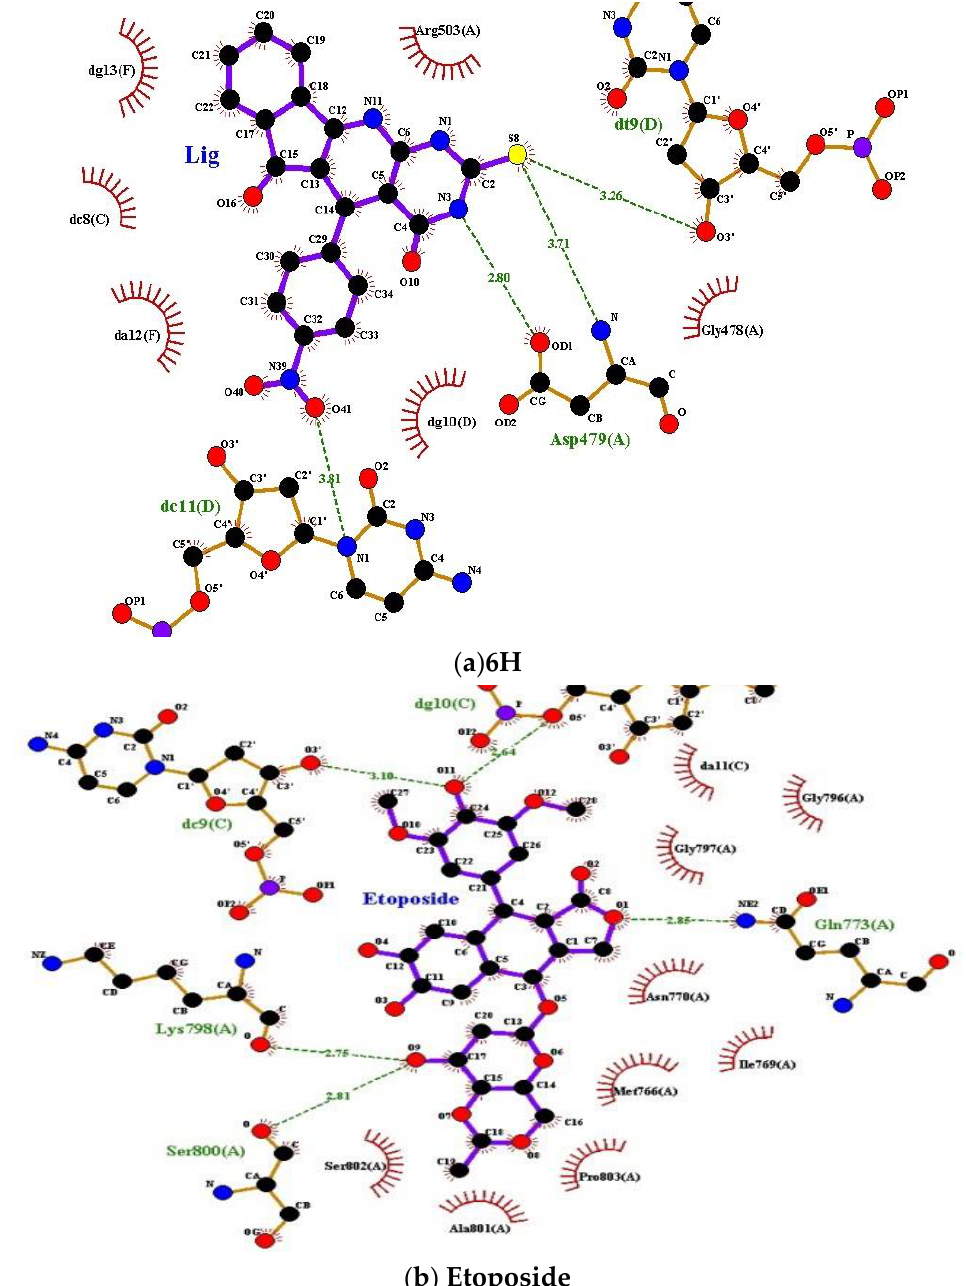
Figure 5. ( a ) Binding sites and interactions of 6H with human DNA topoisomerase II β , 3qx3; ( b ) Binding sites and interactions of etoposide with human DNA topoisomerase II β ,